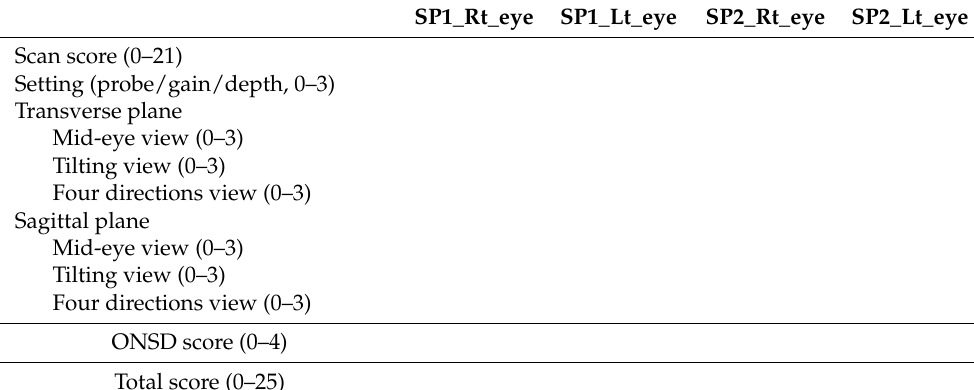
Table A2. The evaluation sheet for ocular POCUS scan performance.